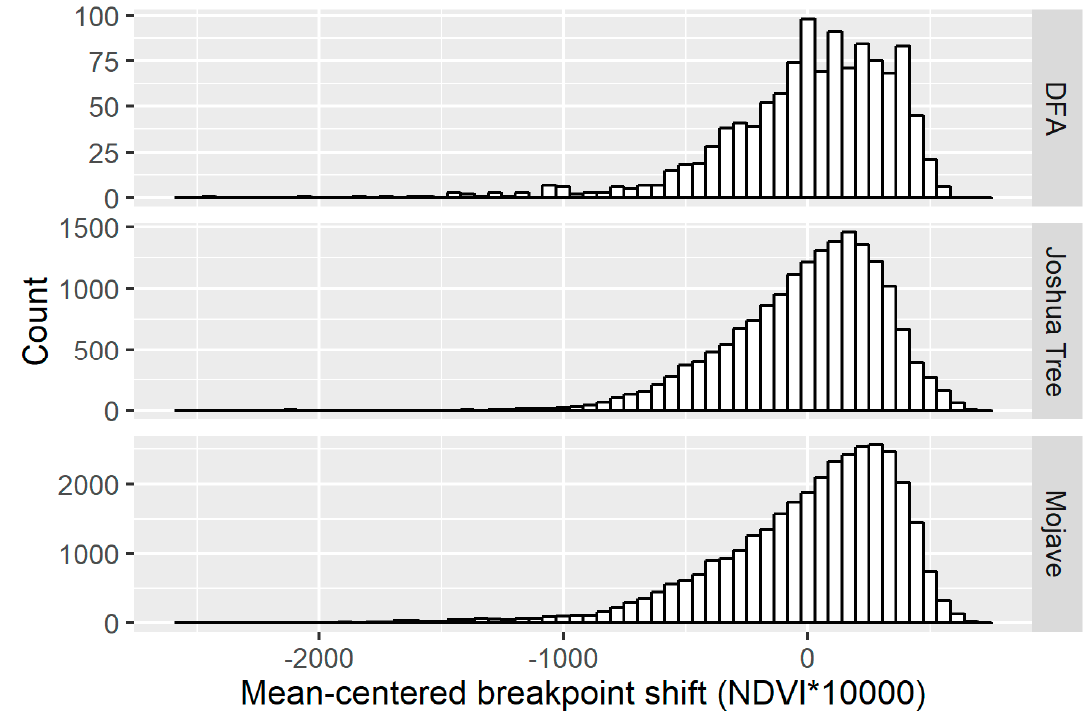
Figure 11. Histograms of negative breakpoint shifts by site.